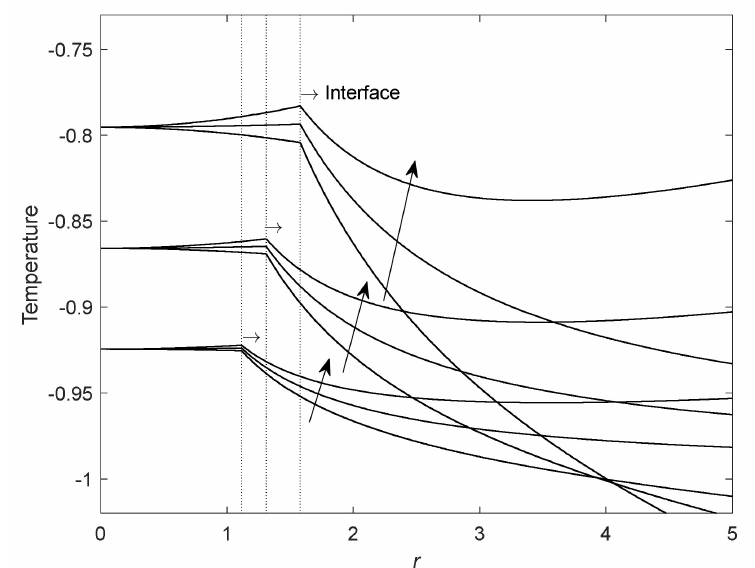
Figure 4. The variations of the temperature near the interface along the growth direction θ = − π /4, 0, π /4 under the dimensionless shear rates s = 15 (from bottom to top) at different times t = 2.0, 4.0, 6.0, where β = 0.20, r 0 = 1.1 R ∗ , Γ = 0.4545, ∆ T = 10. By contrast, the dashed line denotes the columnar crystal growth velocity without the shear